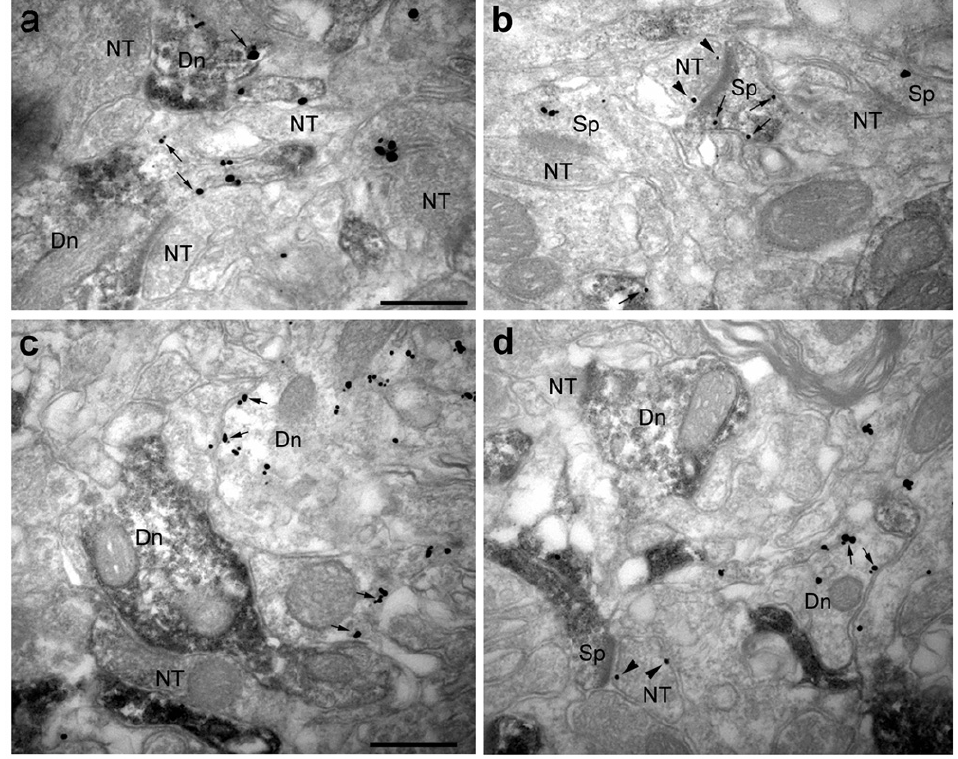
FIGURE 3. Electron micrographs of mouse striatum with double labeling of A 2A receptors with immunogold, and D 1 or D 2 receptors with immunoperoxidase. (a,b) Evidence for colocalization of A 2A receptors (arrows) and D 2 receptors (diffuse dark staining) in dendrites (Dn) and spines (Sp). In (b) there is an example of the uncommon A 2A receptor– labeled nerve terminal (NT; arrowheads) making asymmetric synaptic contact with a double-labeled spine. (c,d) Evidence for the lack of colocalization of A 2A receptors (arrows) and D 1 receptors (diffuse dark staining) in dendrites and spines. In (d) there is an example of an A 2A receptor–labeled nerve terminal (arrowheads) making an asymmetric synaptic contact with a D 1 receptor–labeled spine. Scale bars: 200